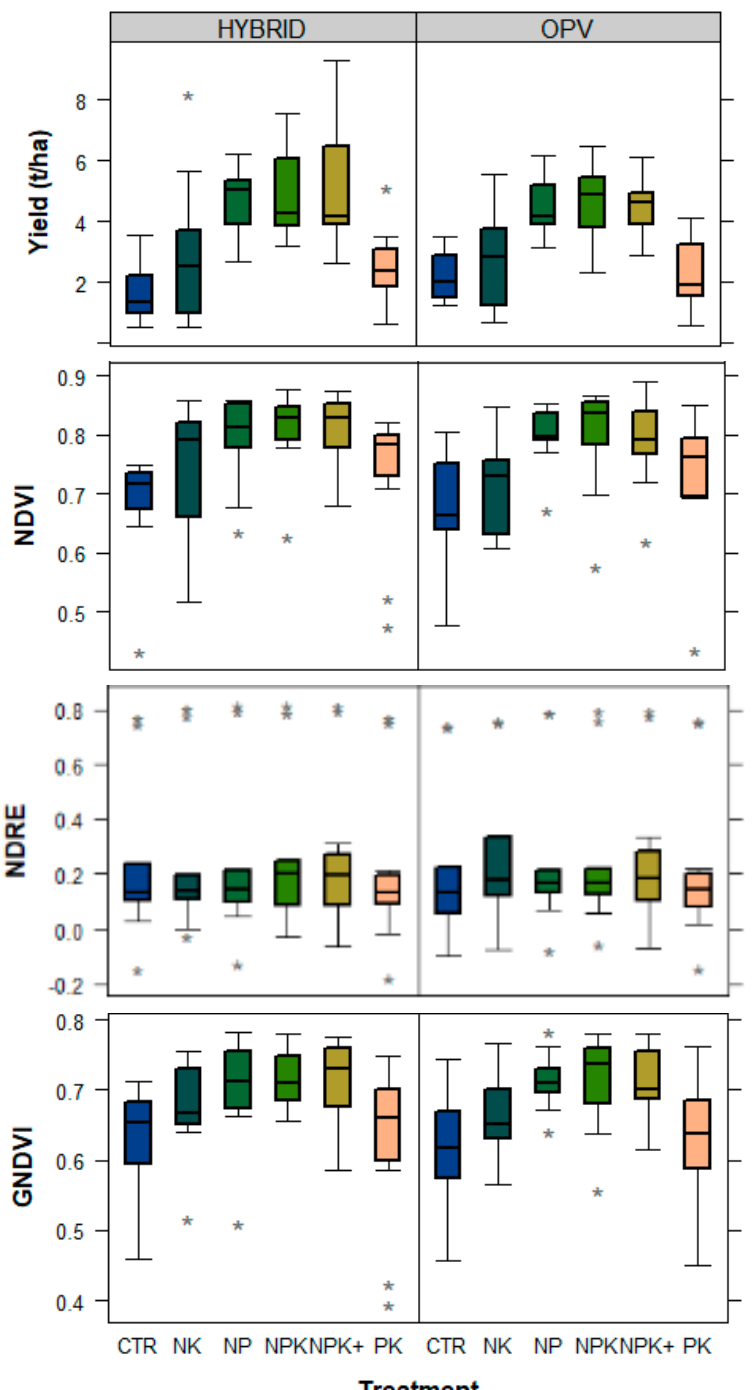
Figure 6. Nutrient-induced variation of UAV-derived vegetation indices (VIs) within multilocational nutrient omission trials (NOTs) in smallholder maize farming systems at 8 weeks after sowing. NDVI denotes Normalized difference VI, NDRE is Normalized difference red-edge, and GNDVI is green normalized difference VI. * and ** denotes outlier data points in the boxplot.